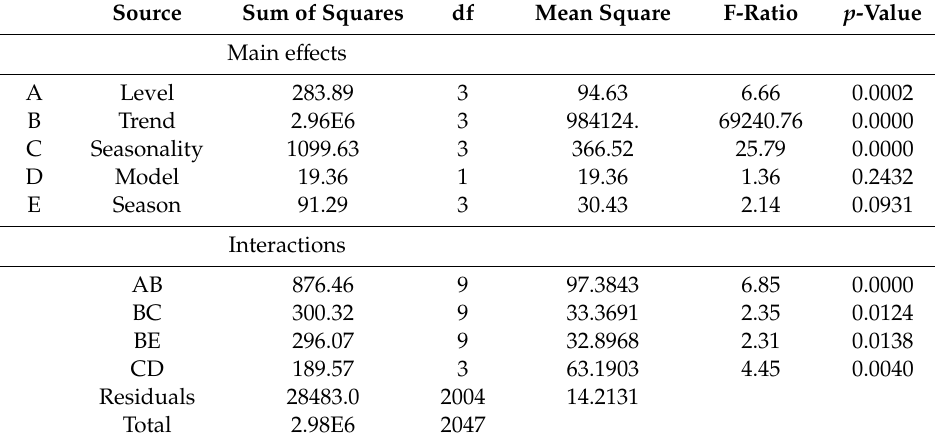
Table 5. Analysis of the variance for the factors studied using the models with multiplicative